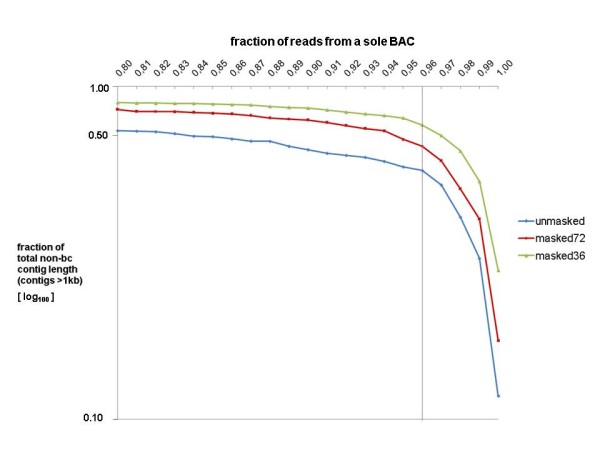
Threshold determination for the classification of contigs as chimeric and non-chimeric in the non-barcoded assemby of BAC pool 2. X-axis: minimal fraction of reads contributed by a sole BAC to a contig. Y-axis (logarithmic): fraction of total length comprised by those contigs. For all 3 assemblies (unmasked, masked in regions with 20mer frequencies >72 and >36) an exponential relationship was observed for fractions from a sole BAC <0.96, followed by a steep decline in the range between 0.96 and 1.00. Therefore, contigs with fractions ≥0.96 were classified as non-chimeric, whereas those <0.96 were regarded as chimeric.